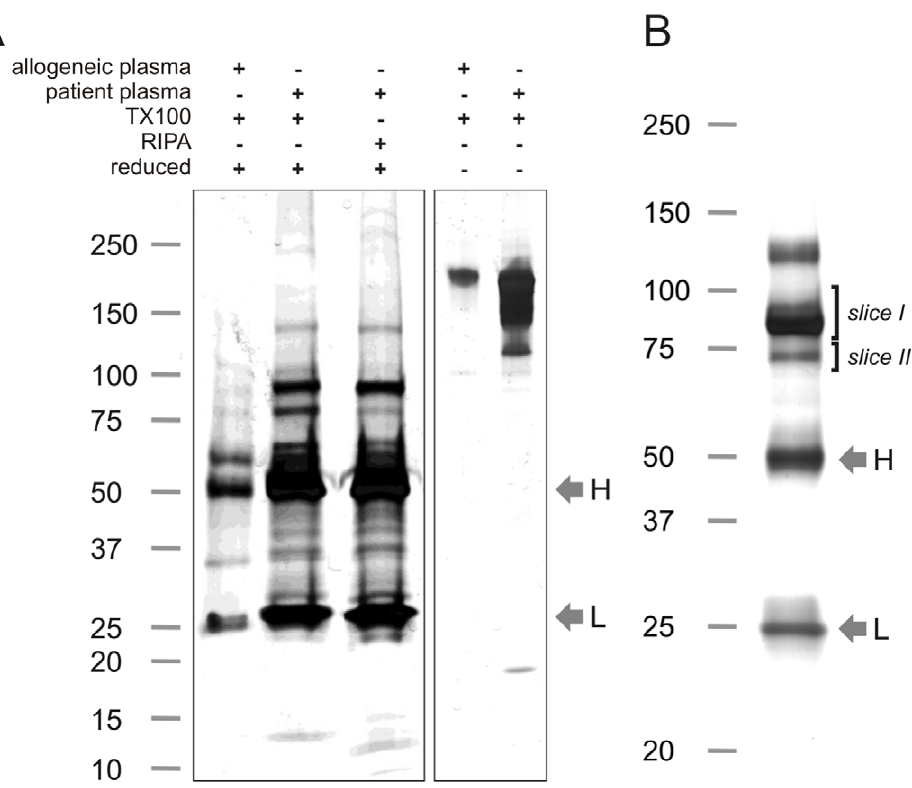
Figure 2. Erythrocyte autoantibody immunoprecipitation of stored erythrocytes. (A) Immunoprecipitation of 35 day old erythrocytes with erythrocyte autoantibody-containing patient plasma and allogeneic control plasma, using TX100 or RIPA extraction buffer and analyzed by SDS-PAGE under reducing or non-reducing conditions, followed by silver staining. A representative result (patient No. 2) from one out of three patient plasmas is shown. (B) Example of a silver stained gel of an immunoprecipitation of 35 day stored erythrocytes with plasma of patient No. 1. The same sample was used for Coomassie blue gel staining and subsequent proteomics analysis (Table 2). Gel slices which were excised for proteomic analyses are indicated as slices I and II (see also Table S1). Numbers indicate molecular weight (kDa). Heavy [H] and light [L] antibody chains are indicated by arrows.